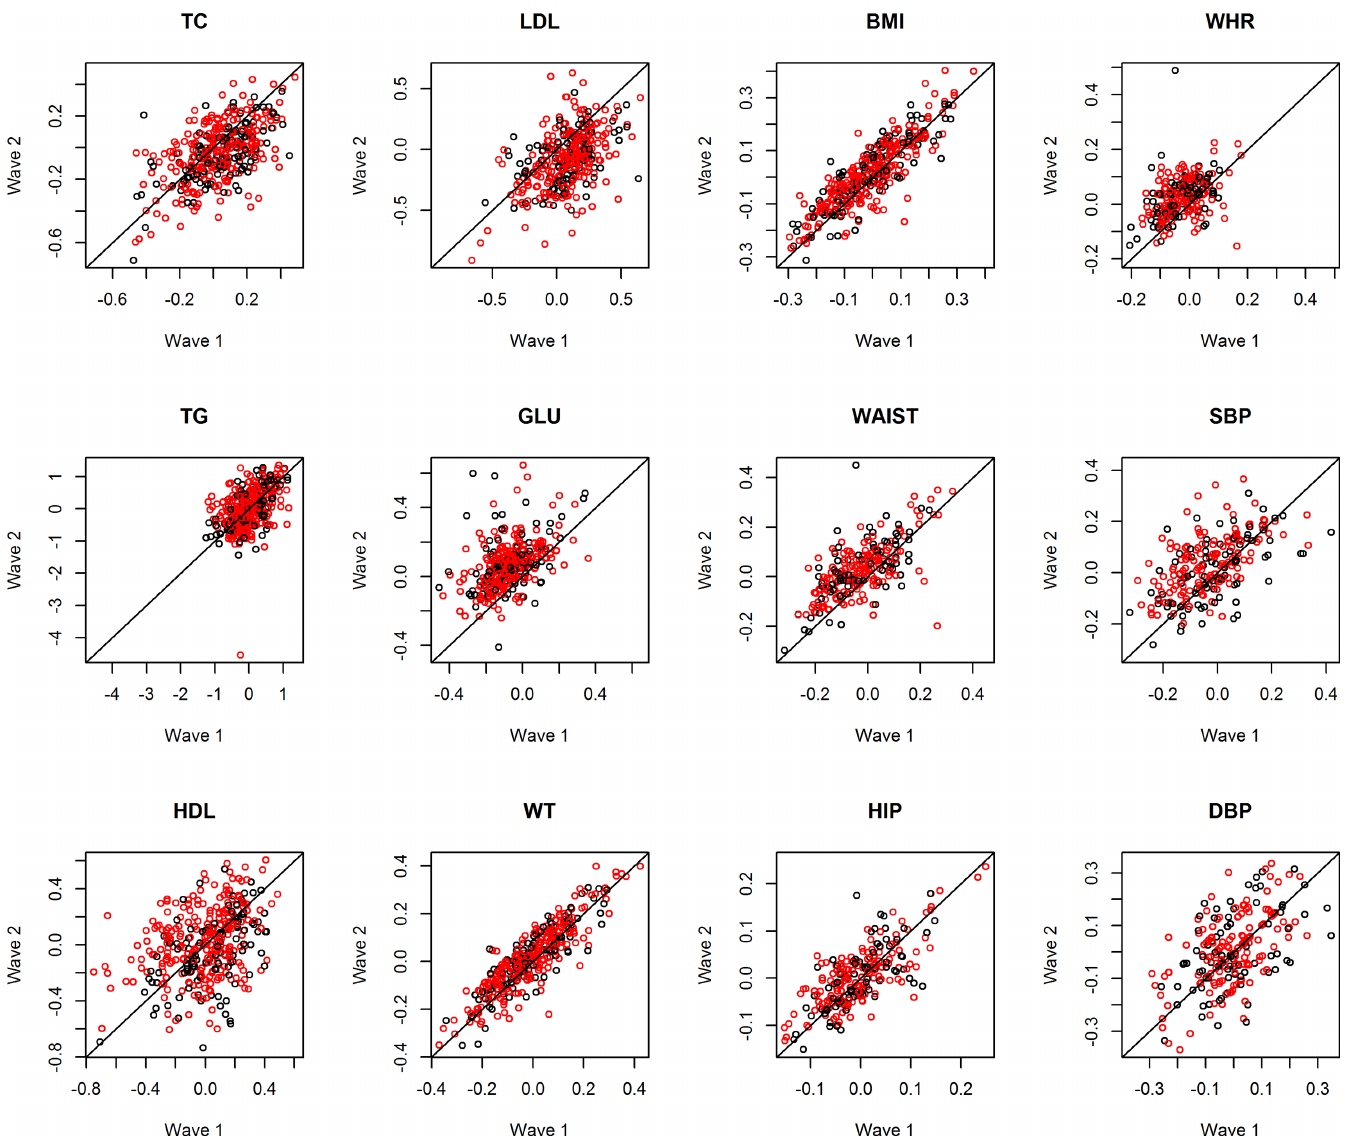
Fig 2. Trend of metabolic phenotypes over time in Chinese twins. Scatter plots showing the residuals of phenotype measurement from the mixed effect model at time 1 (horizontal axis) against that at time 2 (vertical axis) for 12 phenotypes in Chinese twins (females in red; males in black). TC: total cholesterol; TG: triglycerides; HDL: high density lipoprotein cholesterol; LDL: low density lipoprotein cholesterol; GLU: fasting blood glucose; WT: body weight; BMI: body mass index; WAIST: waist circumference; HIP: hip circumference; WHR: waist-to-hip ratio; SBP: systolic blood pressure; DBP: DP: diastolic blood